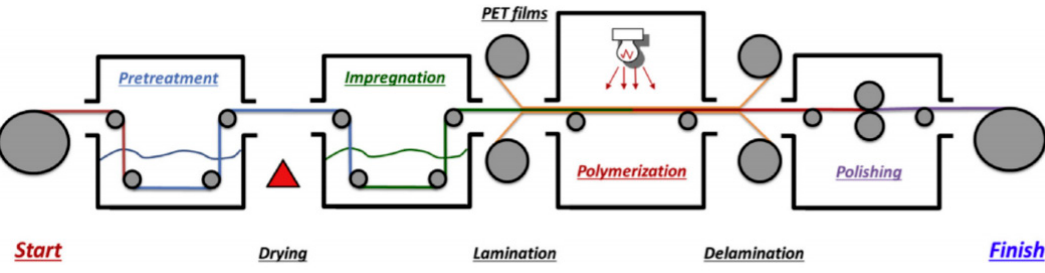
Figure 3. Schematic representation of the PAEM fabrication process using R2R equipment. Reprinted with permission from [72] . Copyright Elsevier, 2019.